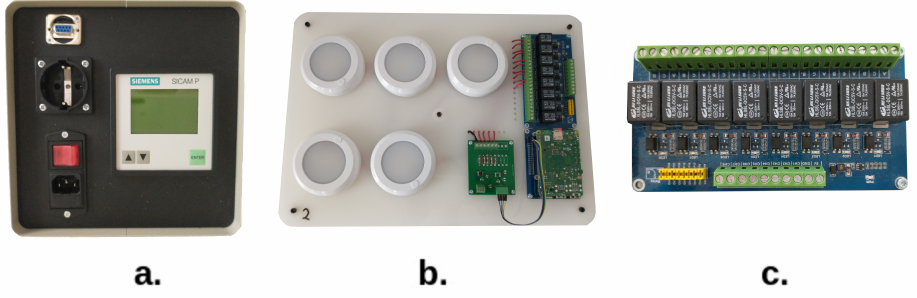
Figure 6. Components of the experimental setup: ( a ) Sicam P50 [51] frequency measuring device. ( b ) On–off controllable LED luminaires. ( c ) Relays that control the LED luminaires.